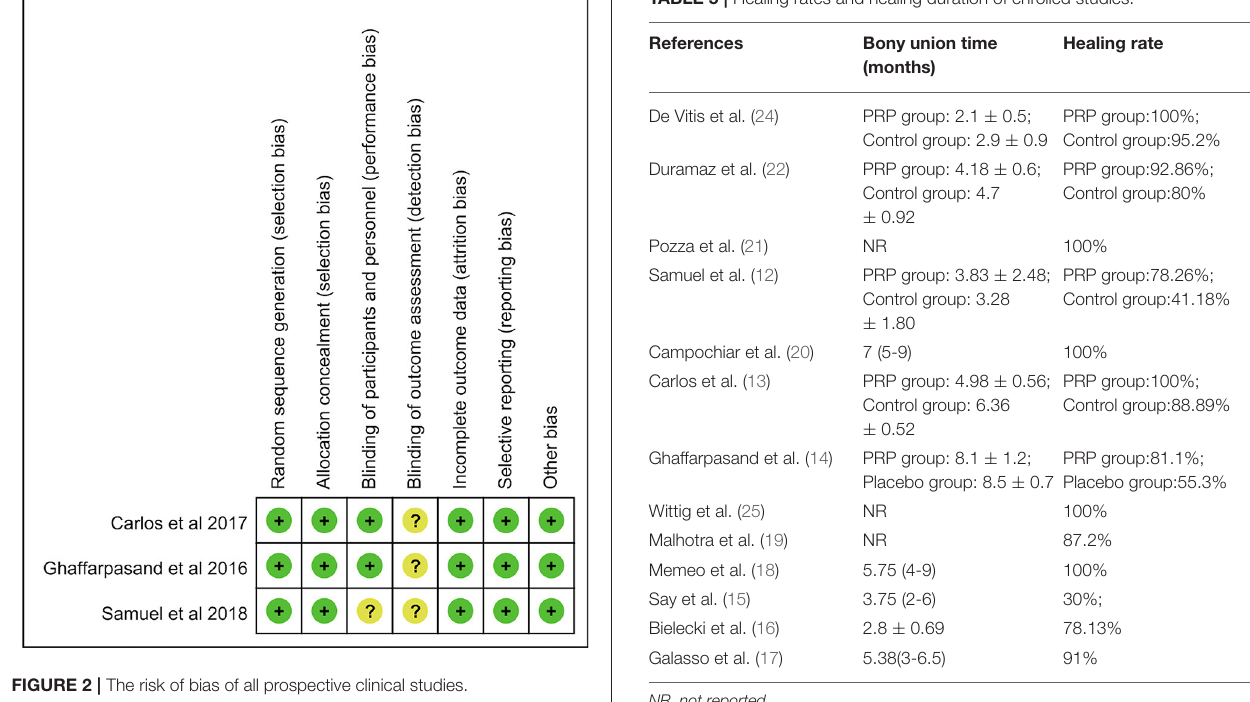
TABLE 5 | Healing rates and healing duration of enrolled studies.